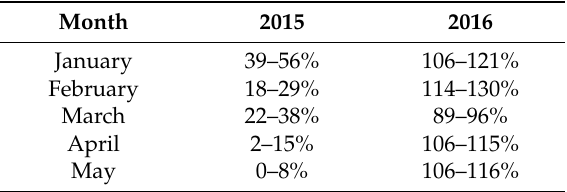
Table 1. Water supply reported as snow water equivalence percent of normal ranges for the Truckee and Carson River Basins. The Lake Tahoe Basin is included as it is also a source of Truckee River waters